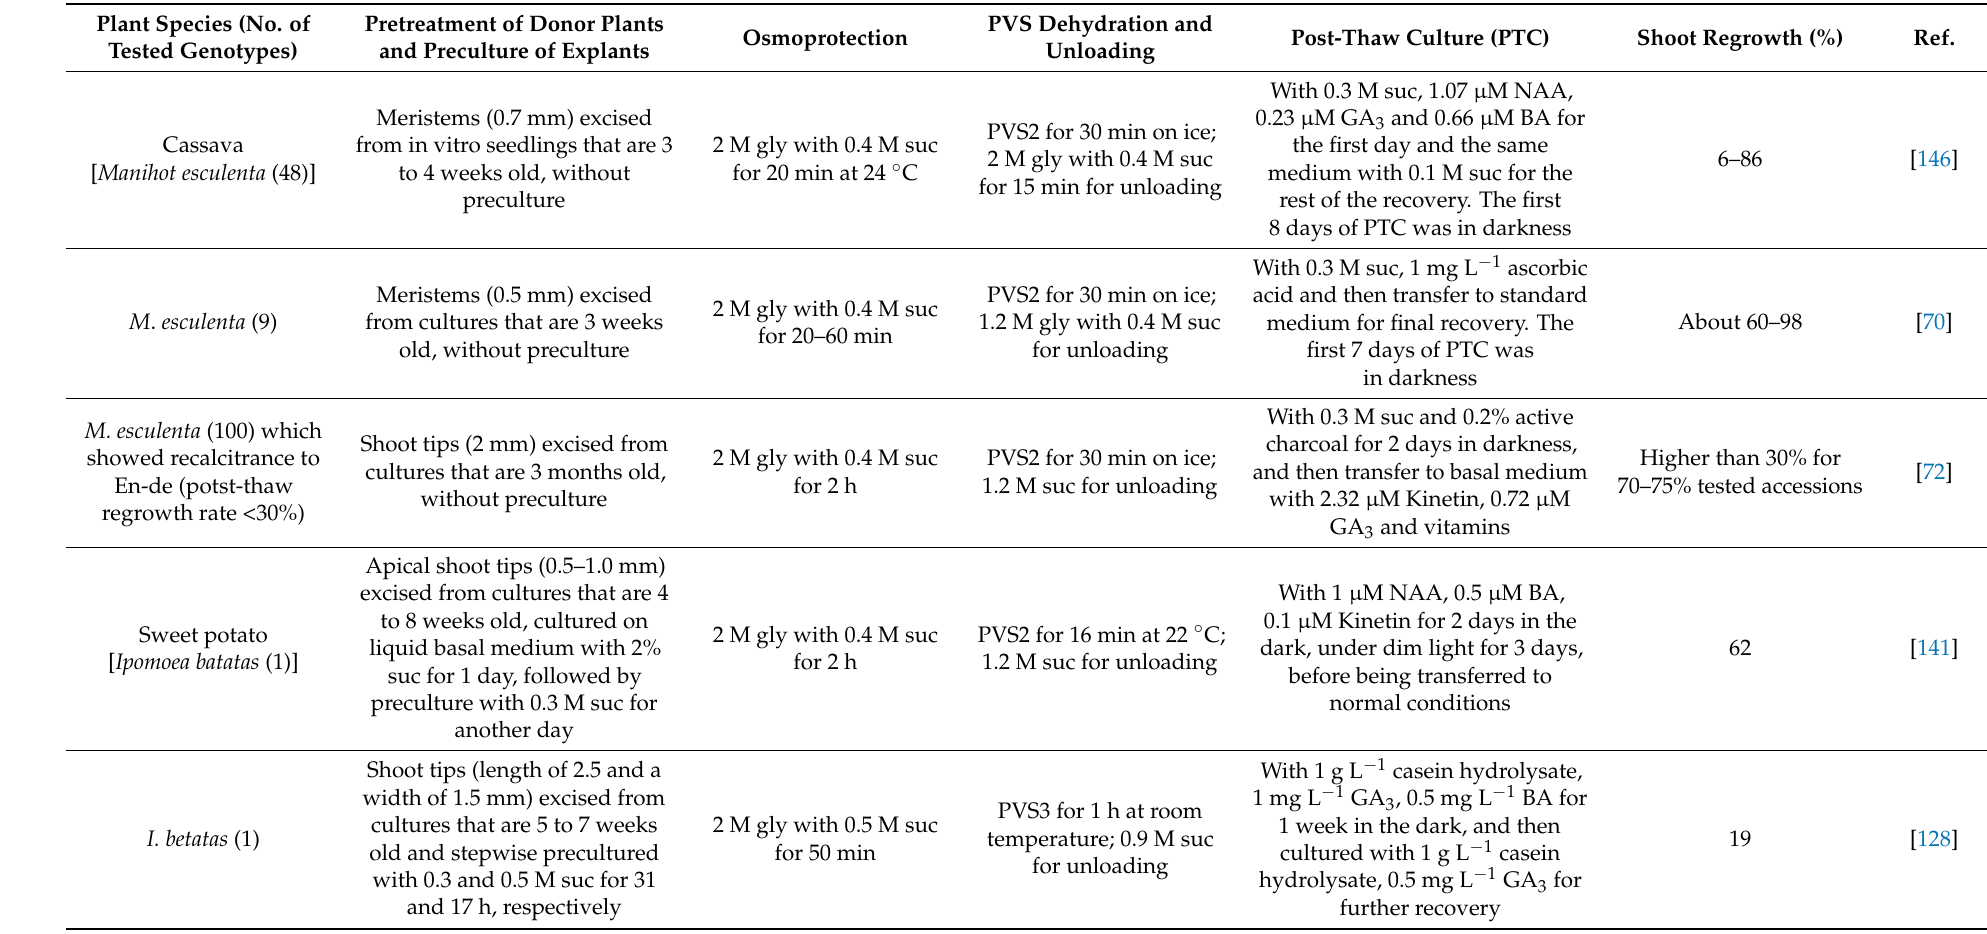
Table 2. The use of Droplet-vitrification for shoot tip cryopreservation of root and tuber crops (RTCs) except potato. Plant Species (No.